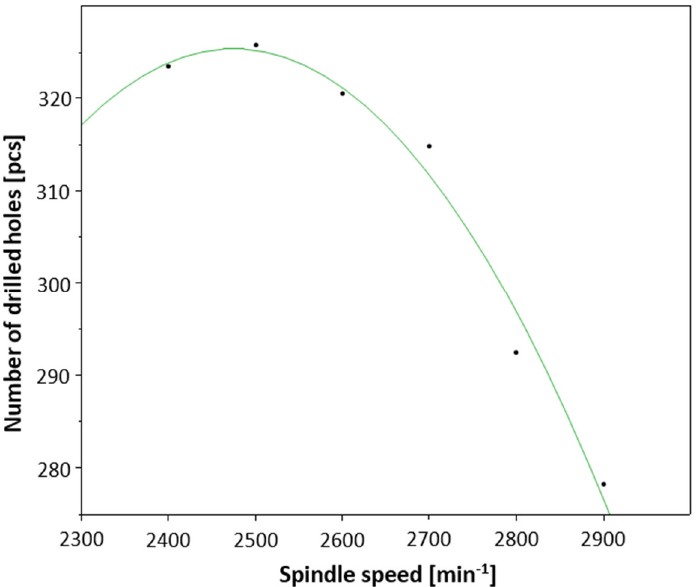
Figure 13. Plotted selected quadratic model of the dependence of the number of holes drilled up to the moment of tool damage on speed change. Table 5. Basic parameters of the quadratic model of dependence of the number of holes drilled up to the moment of tool damage on speed